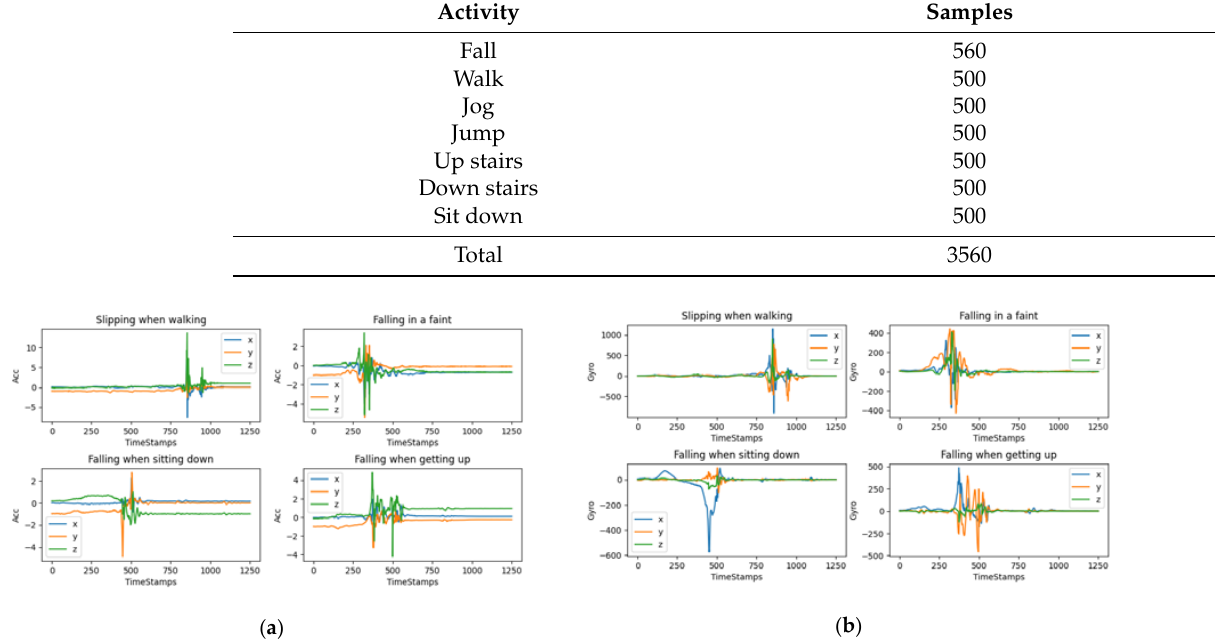
Figure 3. ( a ) Slipping when walking, falling in a faint, falling when sitting down and falling when getting up acceleration graphs; ( b ) slipping when walking, falling in a faint, falling when sitting down and falling when getting up angular velocity graphs.